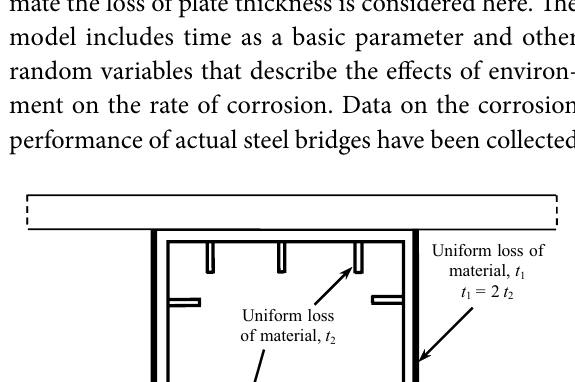
Uniform loss of material, t 2